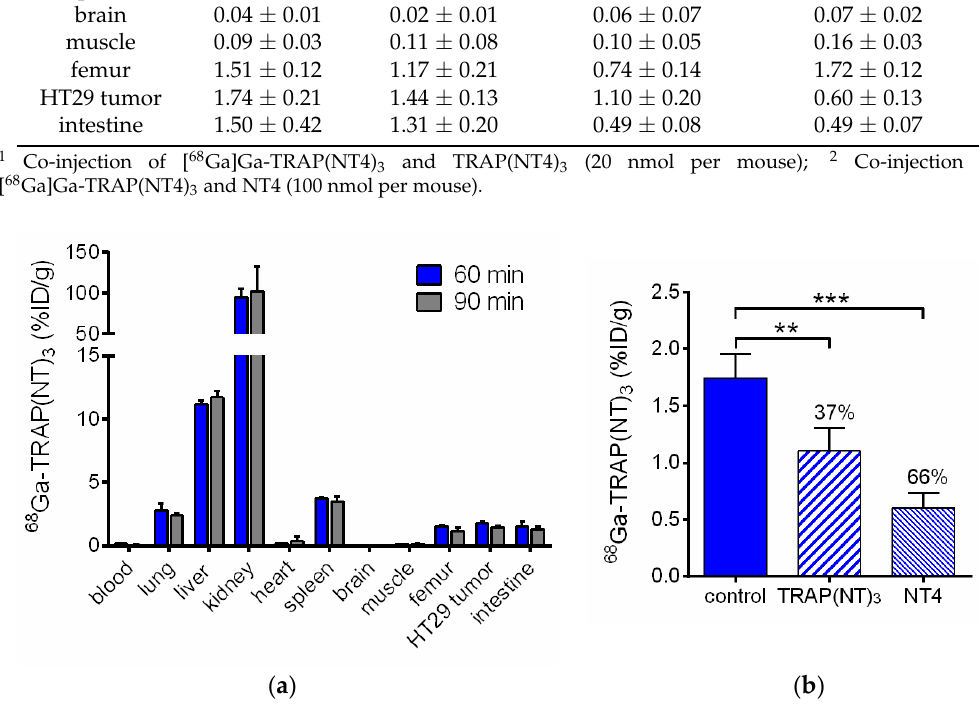
Figure 3. ( a ) Biodistribution of [ 68 Ga]Ga-TRAP(NT4) 3 in HT29 tumor-bearing mice at 60 and 90 min p.i. ( n = 3); and ( b ) blocking of the HT29 tumor by co-injection with TRAP(NT4) 3 (20 nmol, ( n = 3)) or NT4 (100 nmol; ( n = 2)) at 60 min p.i. in comparison with control animals. Each bar represents the